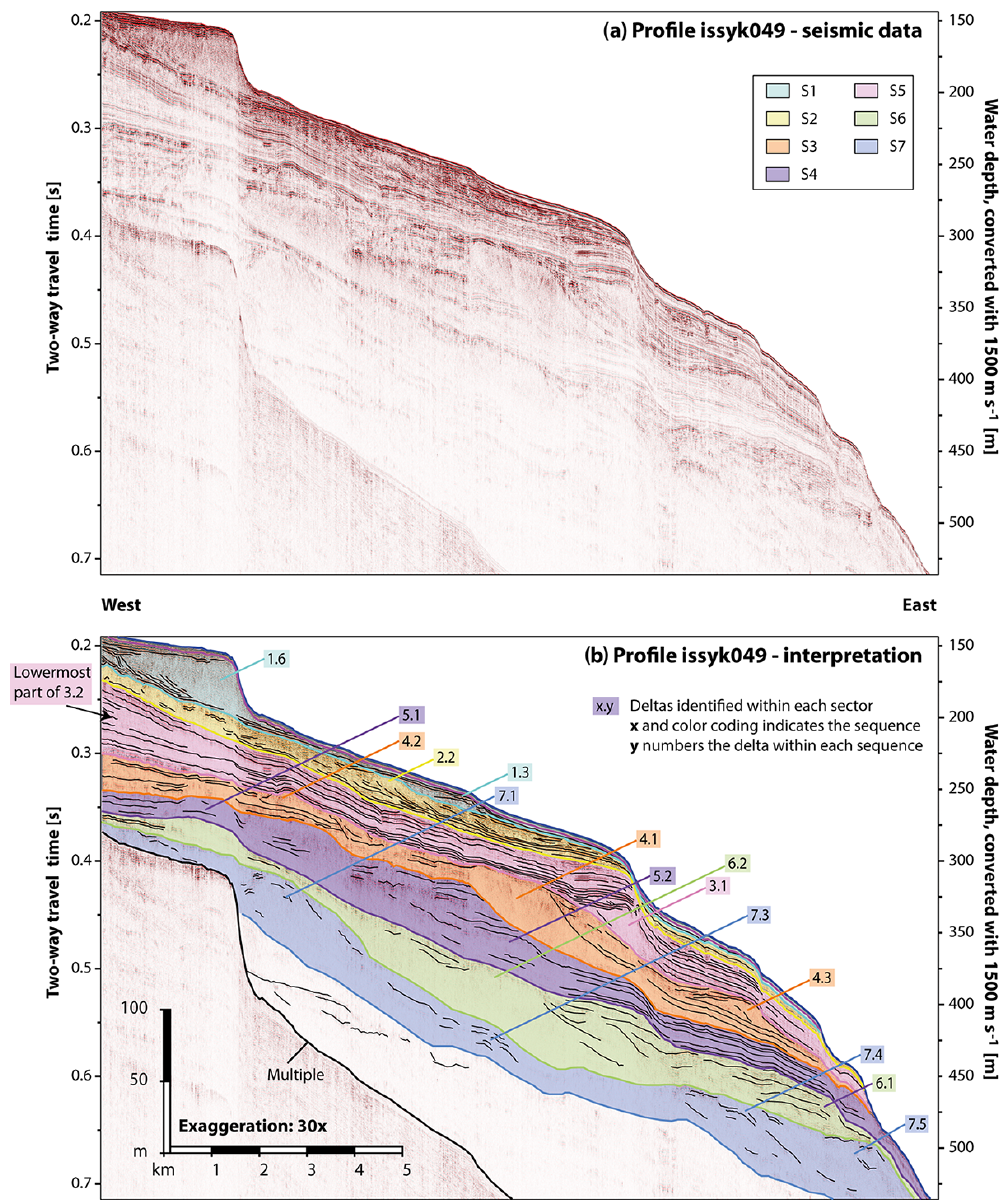
Figure 5. Seismic profile issyk049. Upper panel: seismic data. Lower panel: line drawing and interpretation of all sequences identified in the profile. All delta lobes identified in issyk049 are indicated. See Fig. 1 for location of profile